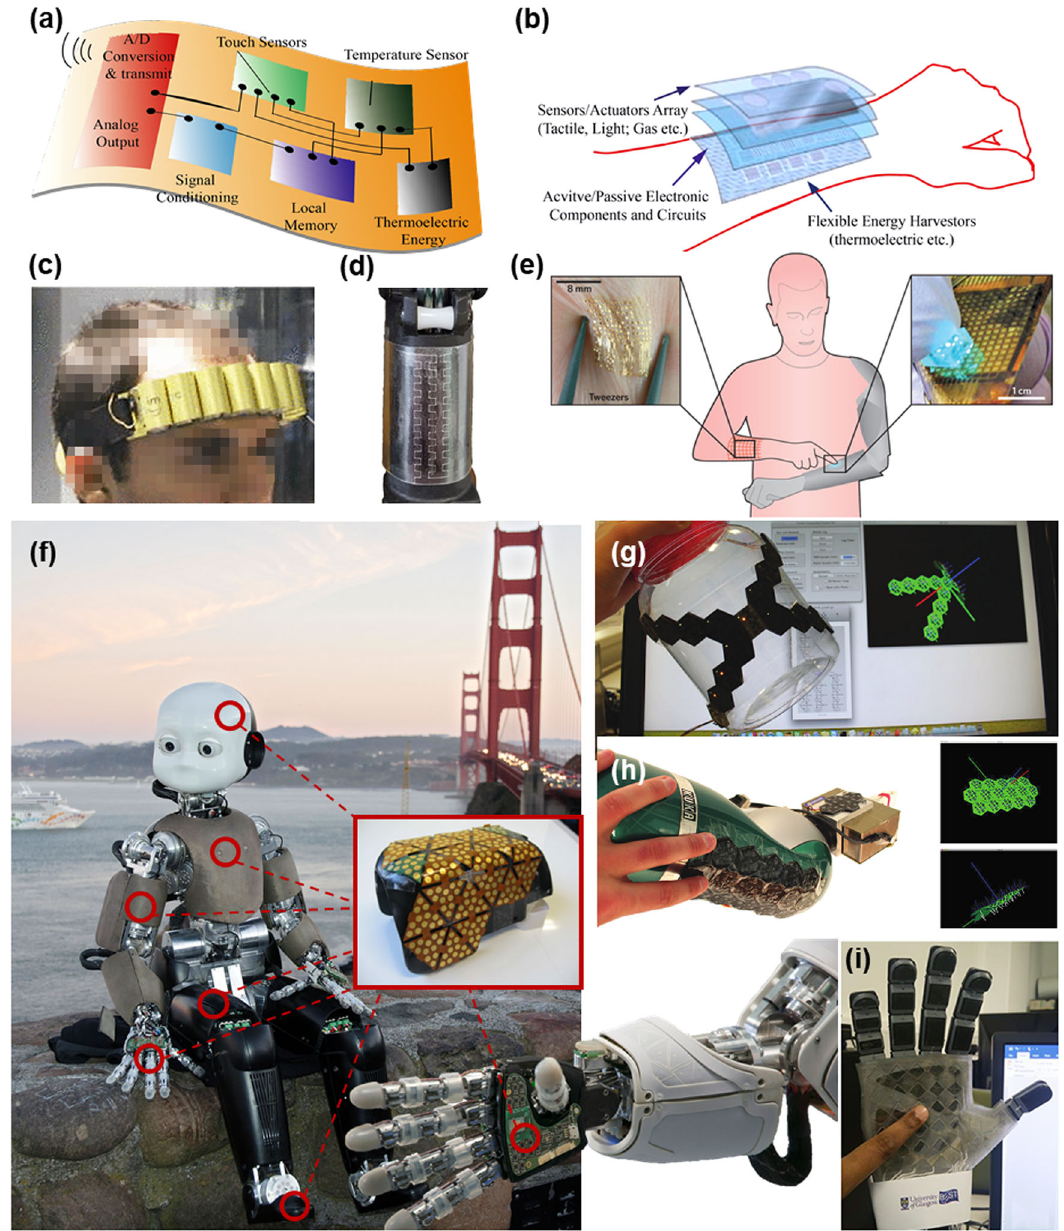
Fig. 1 Multi-sensing and fl exible electronic skin for robots and humans. 3D schema of a fl exible e -skin with multiple electronic components (sensors, electronics, memory, energy harvesters, etc.) distributed a along the same surface or b stacked. Reprinted with permission from Dahiya et al. 211 Copyright © 2015, IEEE. The e -skin self-powered by c a bulky battery (reprinted with permission from Leonov et al. 54 Copyright © 2009, AIP Publishing) or d , e a light-weight wearable solar cell. Reprinted with permission from García Núñez et al. 1 Copyright © 2017, John Wiley and Sons. Reprinted with permission from Bauer et al. 3 Copyright © 2013, Springer Nature. f iCub robotic body and arm covered with e -skin (see inset). Reprinted with permission from Cannata et al. 49,53 The 3D reconstruction of a skin patch placed on g a container, and h a KUKA LWR arm. Reprinted with permission from Dahiya et al. 50 Copyright © 2013, IEEE. i Image of the prosthetic/robotic hand with e -skin.